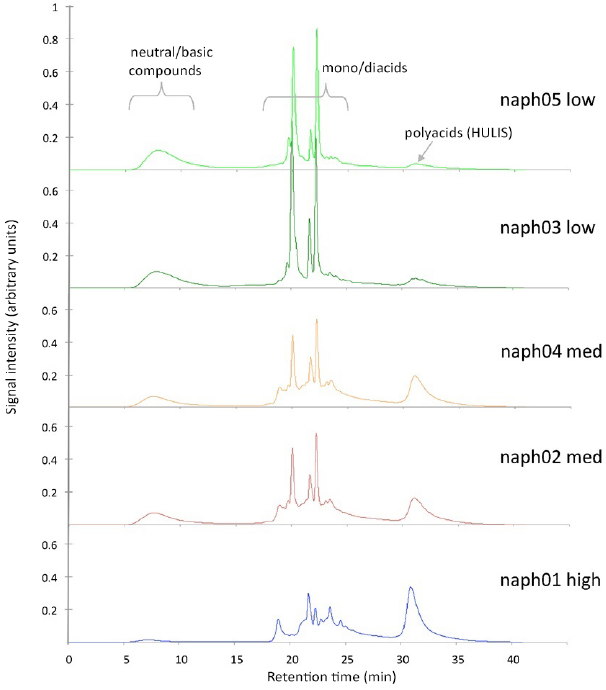
Figure 5. HPLC chromatograms of naphthalene SOA water ex- tracts. Chromatographic features are grouped into neutral, mono- /dicarboxylic acid, and polycarboxylic acid classes based on their affinity for the column phase. Sample identifications are provided in Table